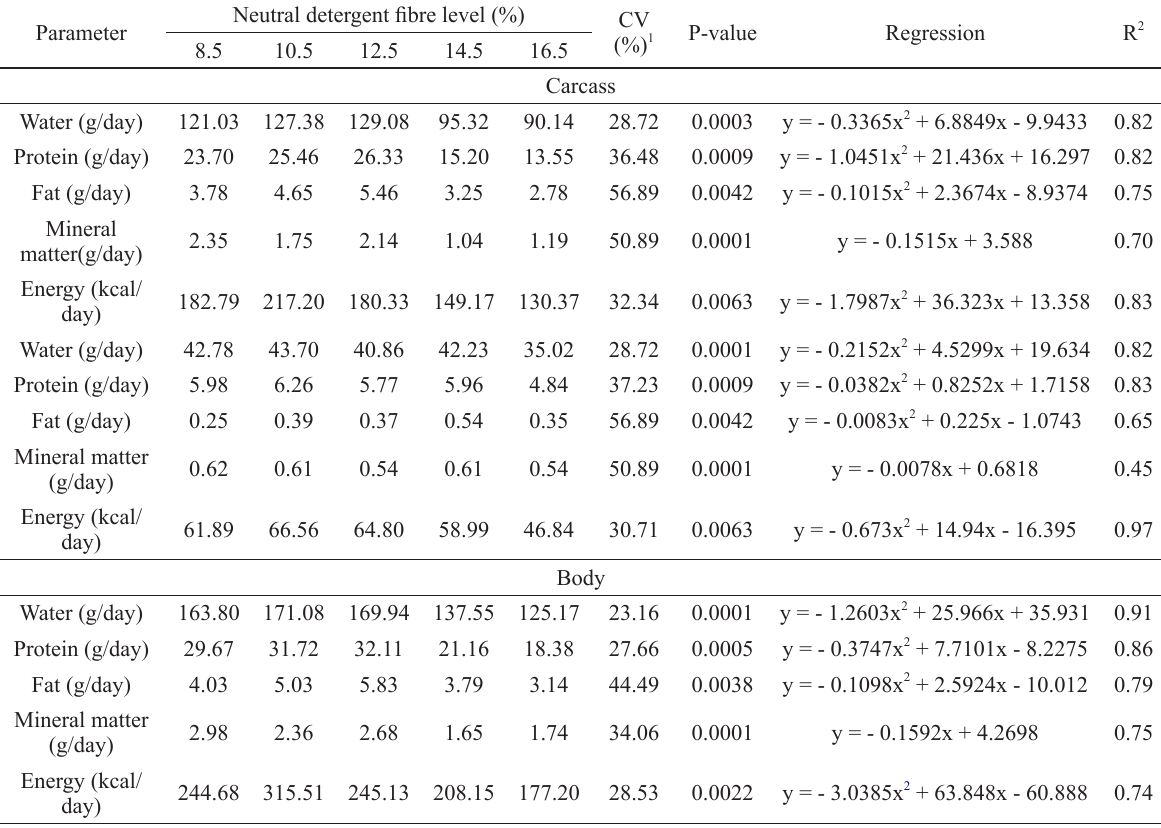
Effect of level of neutral detergent fibre on the rates of deposition of nutrients in the bodies of piglets aged 21 to 42 days.